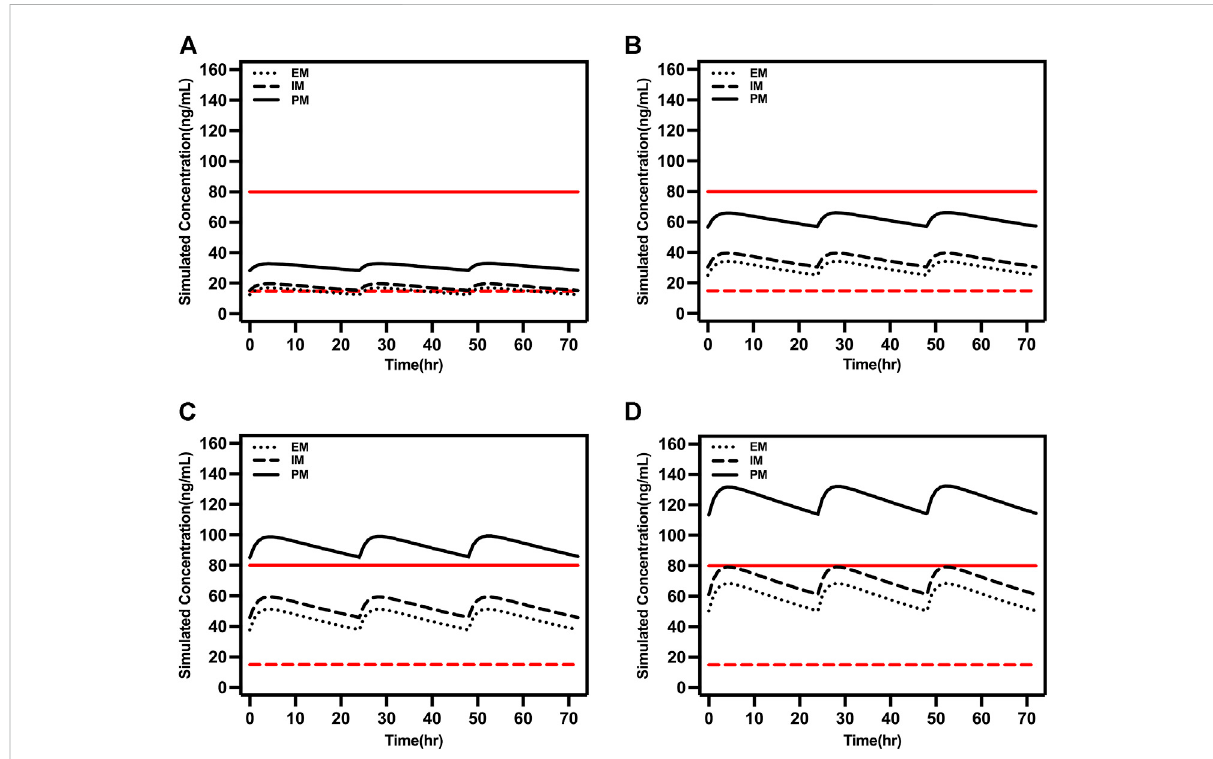
FIGURE 5 SimulatedconcentrationsinEM,IM,andPMolderpatients(65 yearsold)at (A) 5 mg/day, (B) 10 mg/day, (C) 15 mg/day,and (D) 20 mg/day.The red dash lines represented 15 ng/ml and the red solid lines represented 80